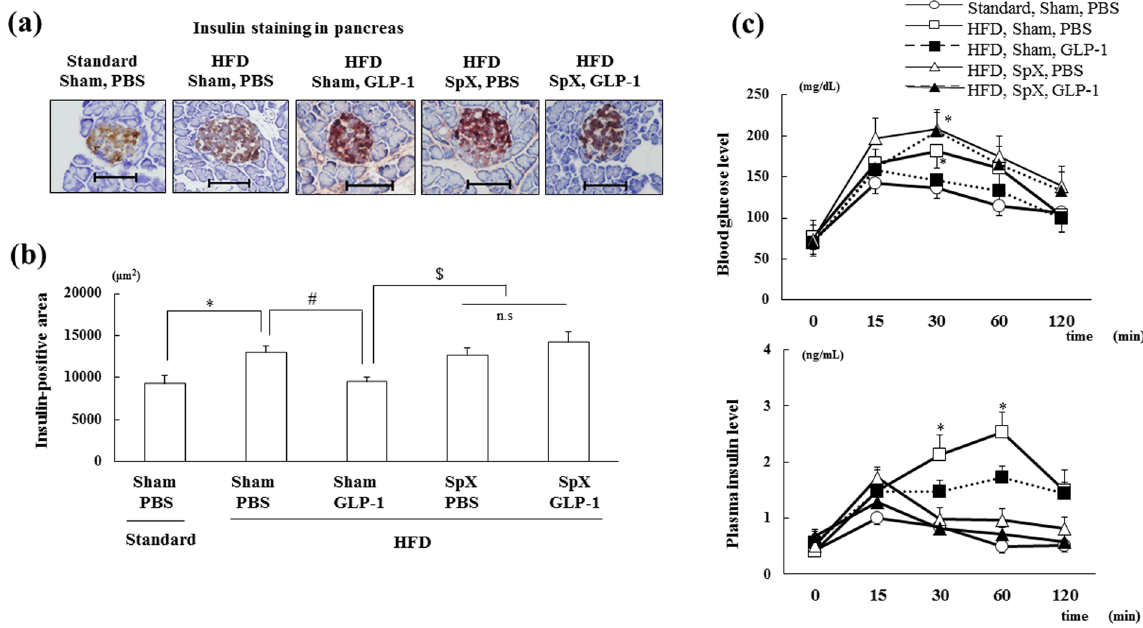
Figure 4. Chronic administration of GLP-1 (7–36) (5 nmol/kg BW) restores the obesity-induced enlargement of β -cell mass and improves glucose metabolism through pancreatic efferent nerves. ( a and b ) Representative insulin staining in islets ( a ) and insulin-positive area ( b ) in each group (n = 6). ( c ) Blood glucose (upper) and plasma insulin (lower) levels during the glucose tolerance tests in each group (n = 6). * p < 0.05 vs. Standard (Sham, PBS) group, # p < 0.05 vs. HFD (Sham, PBS) group, $ p < 0.05 vs. HFD (Sham, GLP-1) group. Treatments: PBS; intraperitoneal administration of PBS, GLP-1; intraperitoneal administration of GLP-1 (7–36), Standard; fed with standard diet, HFD; fed with high-fat diet, Sham; preservation of pancreatic efferent sympathetic nerve with PBS administration, SpX; pancreatic efferent sympathectomy with 6-OHDA administration. Scale bar = 100 μ